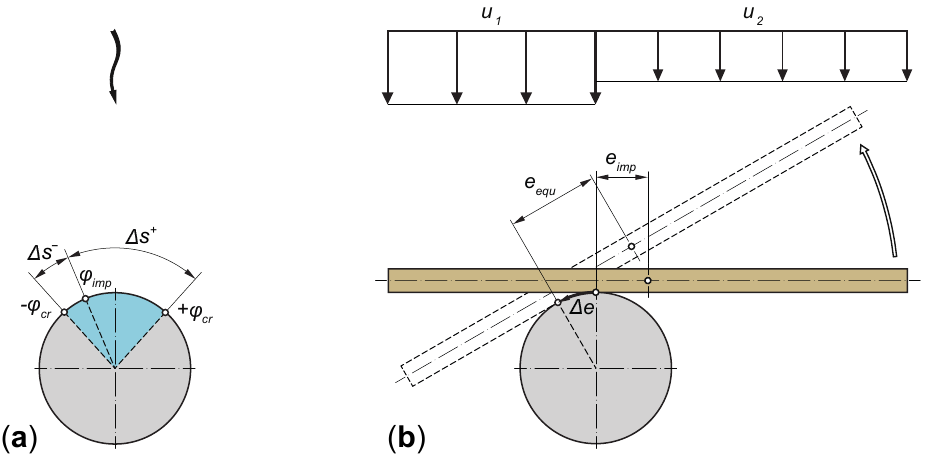
Figure 14. ( a ) Sketch of the critical yaw for ϕ cr = ± 42°. Logs can only accumulate if they impact with a yaw between − ϕ cr < ϕ imp < + ϕ cr (blue area) and do not rotate further than ∆ s − or ∆ s + , respectively. ( b ) Illustration of the rotation of a log from its eccentricity e imp at the impact point to the equilibrium eccentricity e equ with ∆ e = e imp − e equ